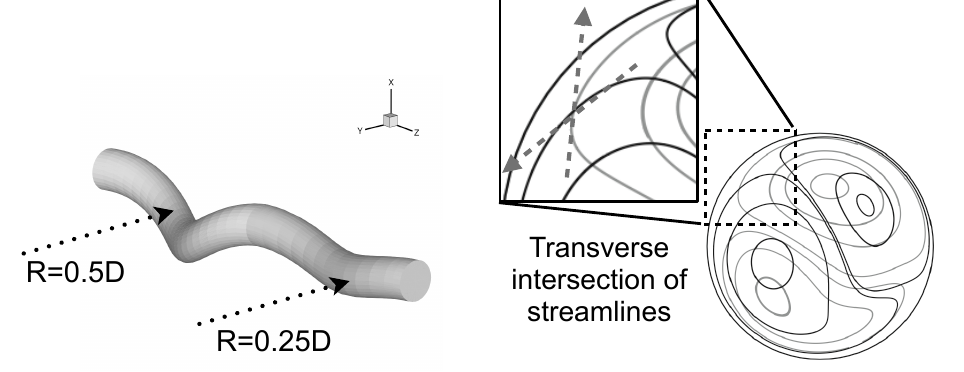
Figure 1. Demonstration of the concept of streamline crossing, which Jones et al. [28] found to produce excellent mixing through chaotic advection in the twisted pipe configuration in ( d ). The same streamline crossing can be embodied in helical geometries by combining pipes of differing radius in a series configuration. (Figure 1e–g reprinted from Journal of Computational and Applied Mathematics, Volume 234, Issue 7, A. N. Cookson, D. J. Doorly, S. J. Sherwin, Using coordinate transformation of Navier—Stokes equations to solve flow in multiple helical geometries, pp. 2069–2079, Copyright (2009), with permission from